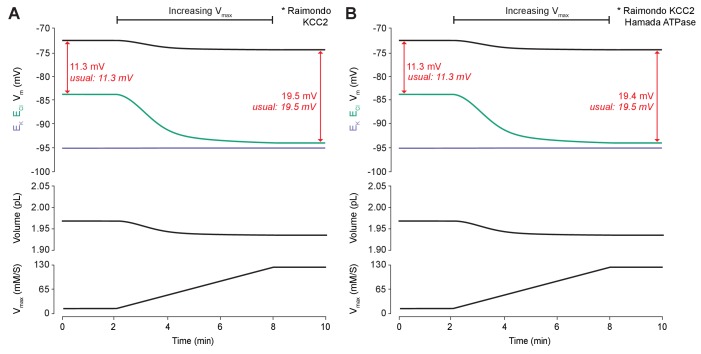
KCC2 and ATPase models with different kinetics have similar properties when KCC2 is upregulated.(A) Increasing KCC2 activity in our model using the Raimondo et al. (2012) model by increasing Vmax/JScale resulted in a persistent decrease in ECl (green), a minimal decrease in EK (purple), Vm (black) and volume w (bottom panel). This resulted in a permanent increase in the driving force for Cl-. The change in KCC2 strength was matched so that the final shift is similar to the usual shift in driving force gained using our standard KCC2 pump formulation. (B) When the ATPase model of Hamada et al. (2003) was used in the experimental set up in (A) rather than the usual ATPase model, the resulting driving force differed by only 0.1 mV from the usual value.